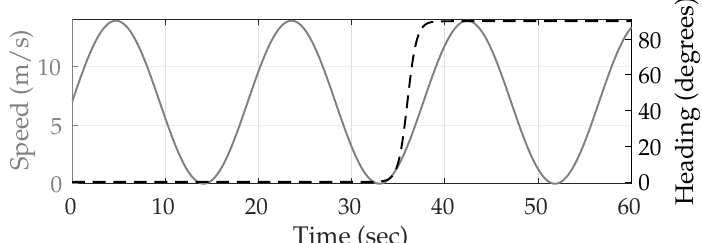
Figure 4. Vehicle speed (solid line) and heading (dashed line) simulating stop-and-go motion with a 90 ◦ right